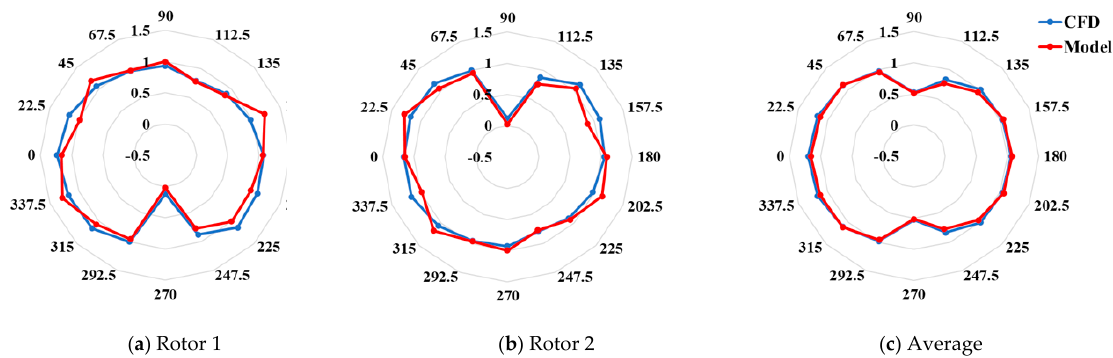
Figure 15. Distributions of normalized rotor powers in the CO-configuration in the case of gap = 2.0 D : ( a ) Rotor 1; ( b ) Rotor 2; ( c ) average.